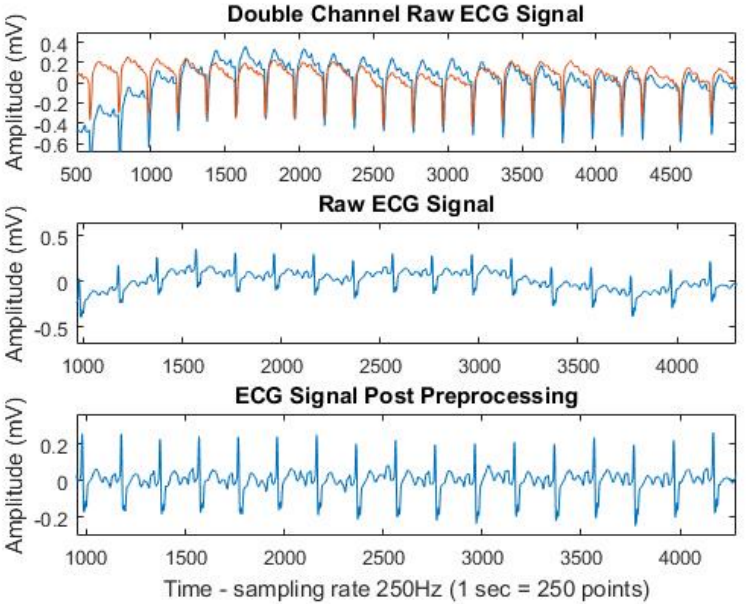
Figure 3. Raw double channel ECG signal, raw single channel ECG signal prior to pre ‐ processing and ECG signal after pre ‐ processing with baseline wander removal.